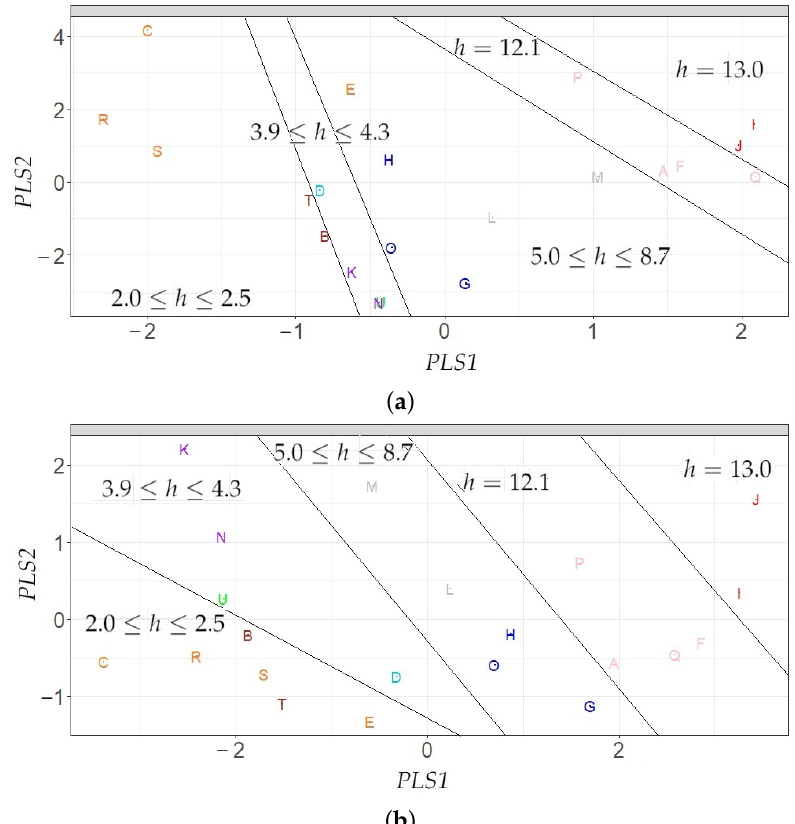
Figure 11. Projection of sensors over the two relevant components (PLS1 and PLS2) on the subspace spanned by the regressor data sets from sPLS; ( a ) using variables from Method 1 and ( b ) Method 2. Sensor codes, represented by letters, as in Figure 4, which were colored according to their height: 13.0 m in red, 12.1 m in pink, 8.7 m in gray, 5.0 m in blue, 4.3 m in green, 4.0 m in purple, 3.9 m in cyan, 2.5 m in brown, and 2.0 m in orange. Solid tilted lines were inserted to better reflect the distribution of nodes in both plots according to